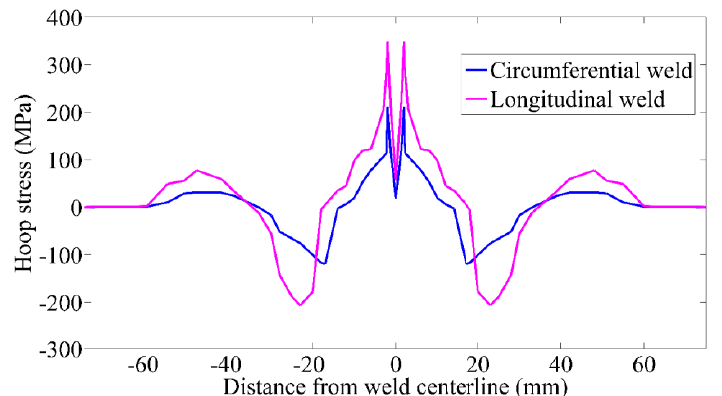
Fig. 16. Residual hoop stress distribution on the outer surface for circumferential and longitudinal weld butt joints.